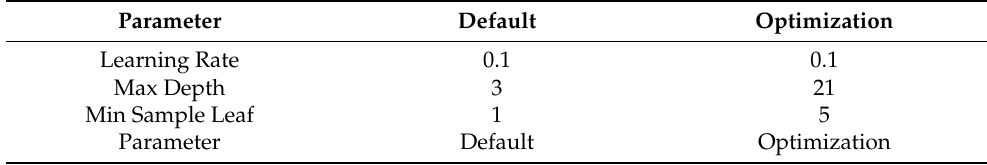
Table 2. Hyperparameters used in the GBRT prediction model.